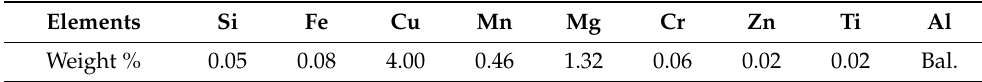
Table 1. Composition of AA2024 alloy.